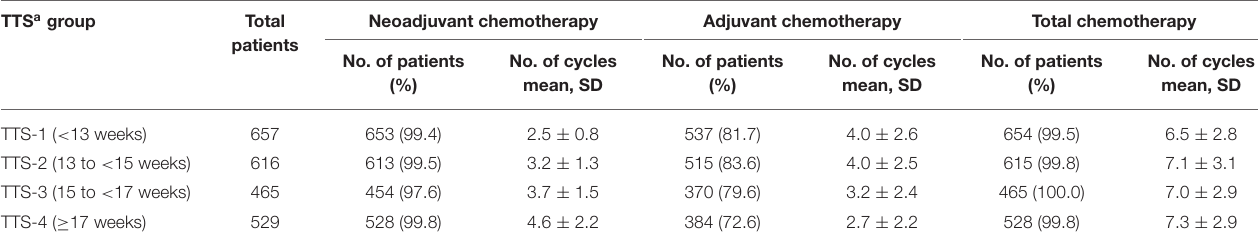
TABLE 2 | Neoadjuvant, adjuvant, and total chemotherapy cycles, by total-time-to-surgery (TTS) a , in 2,267 patients with locally advanced rectal cancer, January 2010 through December 2018. TTS a group Total Neoadjuvant chemotherapy Adjuvant chemotherapy Total chemotherapy patients No. of patients No. of cycles (%) mean,